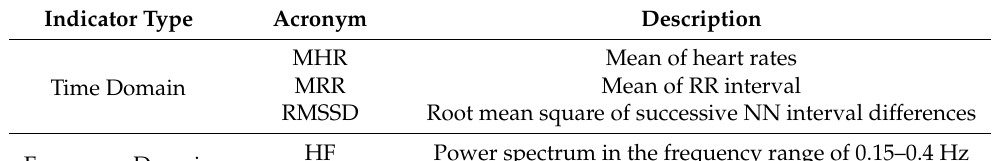
Table 1. ECG indicators selected for the study and their description.